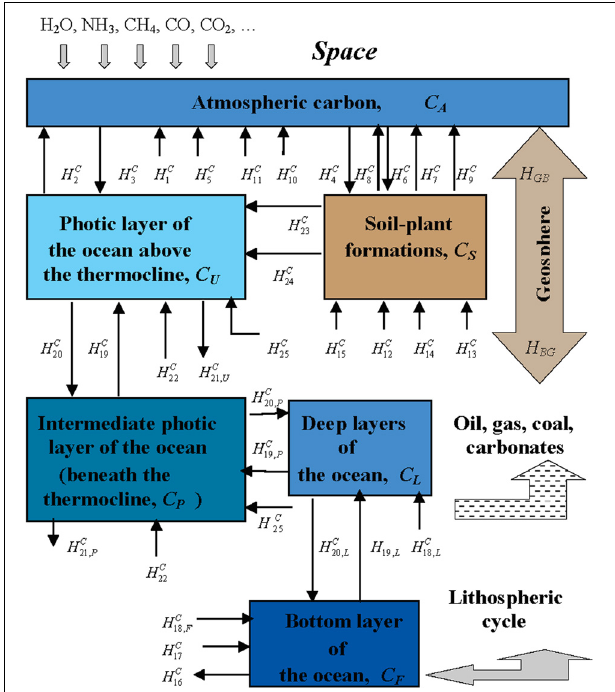
FIGURE 5 | The block-diagram of the CO 2 cycle considering the global biogeochemical processes in the atmosphere-land-ocean system. The corresponding details about CO 2 are given in Table 1 (Kondratyev et al., 2006).